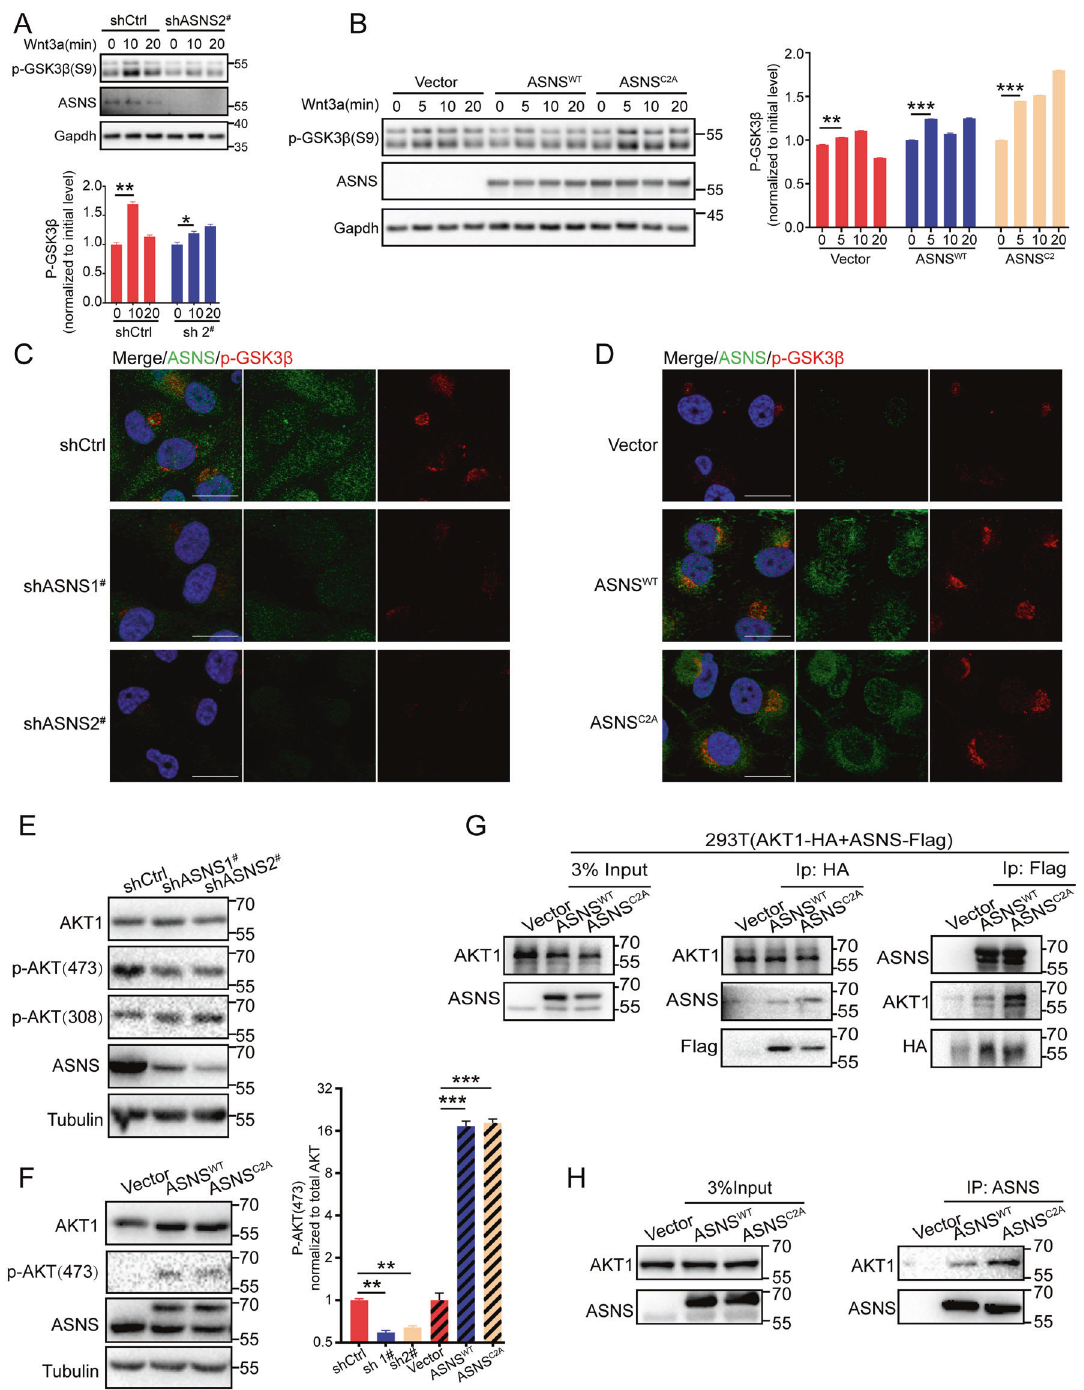
Fig. 6 ASNS interacts with AKT and promotes GSK3 β phosphorylation on ser9. p-GSK3 β (S9) was an inactivated type of GSK3 β , under Wnt3a treatment, the whole-cell phosphorylated GSK3 β level was extracted by 2% SDS lysis buffer and detected by western blot in ASNS knockdown ( A ) and overexpressed ( B ) cell lines. C , D cells were permeabilized by 0.1% Triton X100 for 10 min, then phosphorylated GSK3 β levels were detected by immuno fl uorescence. AKT was an essential upstream protein for GSK3 β phosphorylation. Total AKT and phosphorylated AKT (active) levels were detected in ASNS knocked down ( E ) and overexpressed ( F ) cell lines. G AKT-HA and ASNS-FLAG plasmids were transfected into HEK-293T cell lines for 2 days, then puri fi ed AKT or ASNS proteins by magnetic beads for co-immunoprecipitated detection. H ASNS proteins were puri fi ed by IgG magnetic beads, then targeted for co-immunoprecipitated detection. The different protein levels between groups were tested by Student ’ s t test. Error bars were expressed as mean ± S.D. P < 0.05 is signi fi cant statistic difference, * p < 0.05, ** p < 0.01, *** p < 0.001. Representative images from three independent experiments are